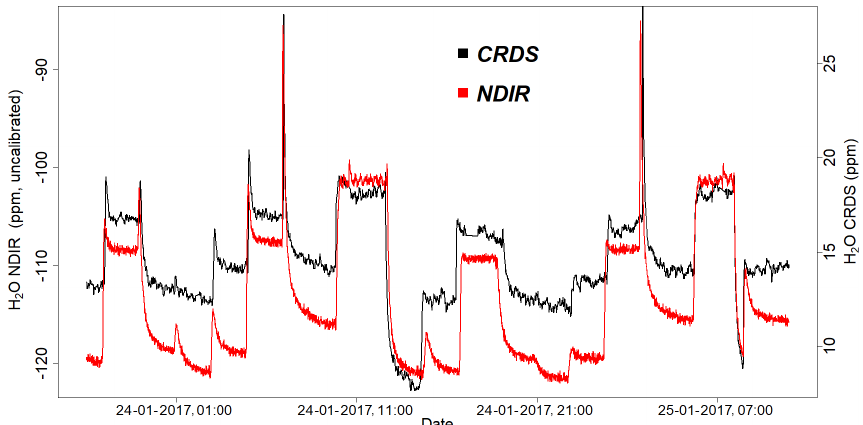
Figure 14. Parallel water vapor measurements for a dried ambient air from both the NDIR and CRDS analyzers. Note that the water values from the NDIR analyzer are not